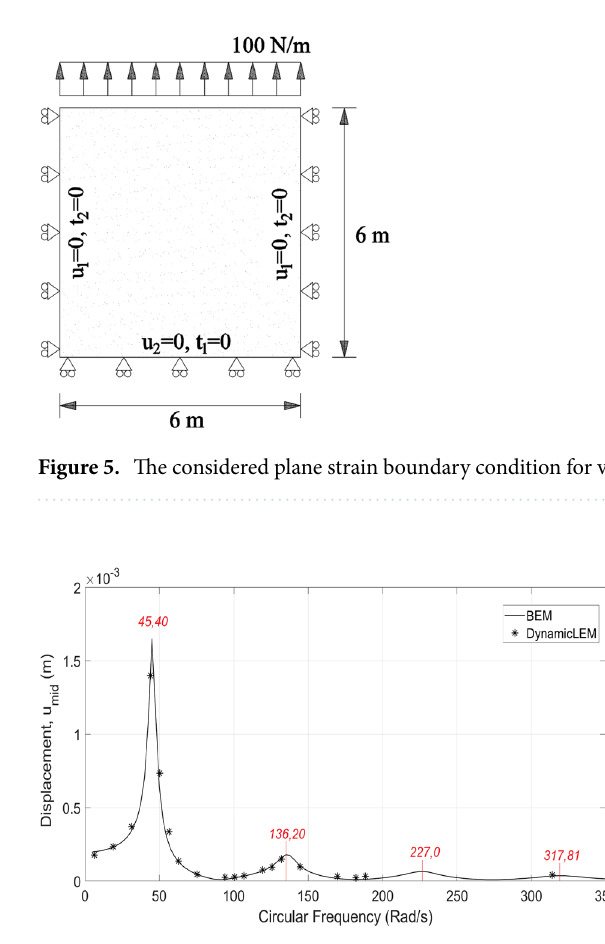
Figure 6. The comparison of BEM solution and dynamic lattice method results of displacements in mid-point of upper boundary ( u mid ) under different circular